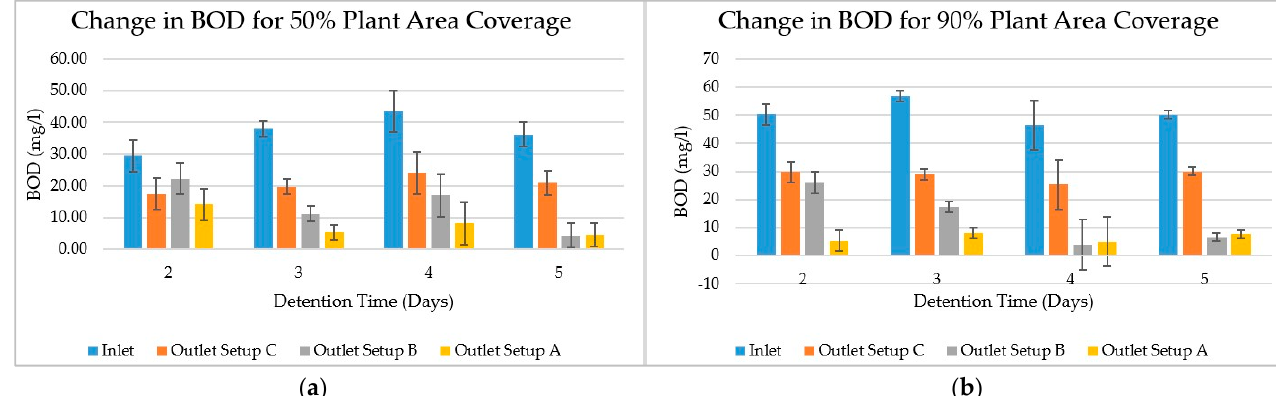
Figure 5. Change in BOD with respect to Detention Time: ( a ) Change in BOO for 50% plant area coverage; ( b ) Change in BOD for 90% plant area coverage .